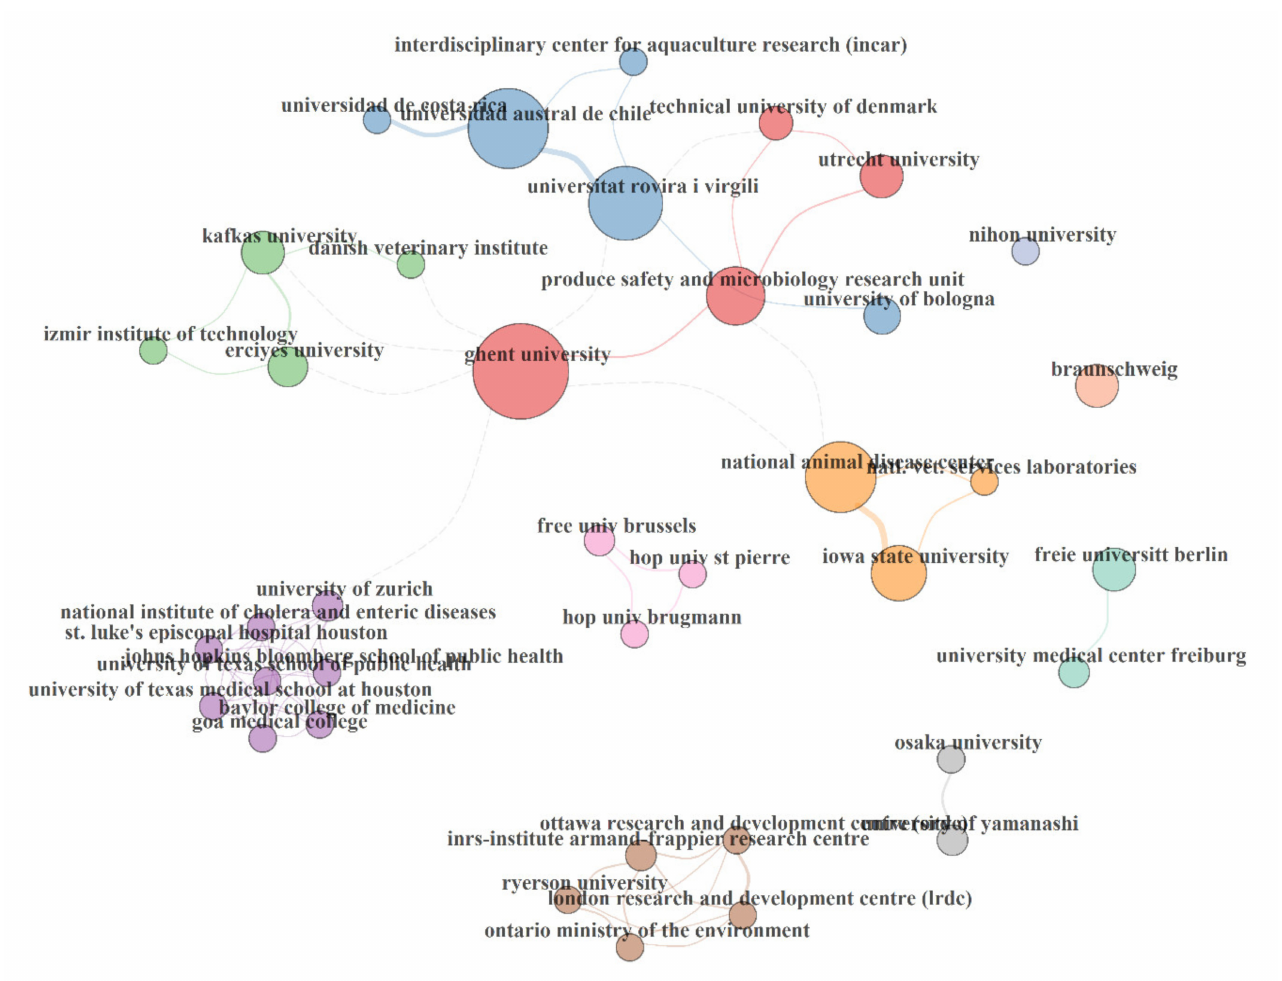
Figure 5. Institutions’ collaboration